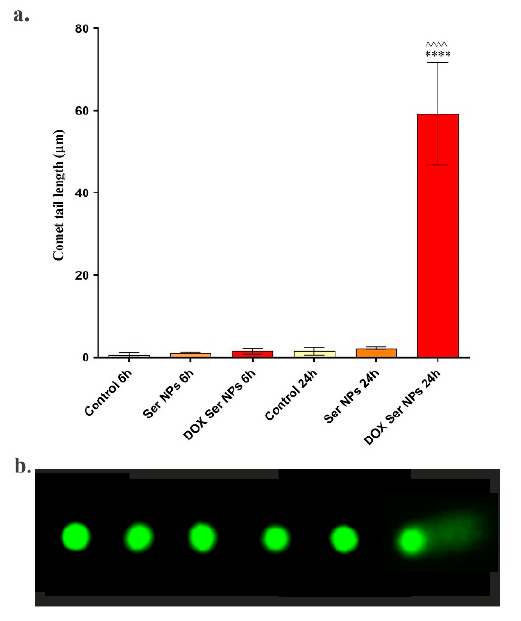
Figure 12. ( a ) Graphical representation showing the comet tail length as an indicator of DNA damage in MCF–7 cell cultures treated for 6 h and 24 h with simple and DOX-loaded Ser NPs (Dox Ser NPs vs. untreated control **** p ≤ 0.0001; Dox Ser NPs vs. Ser NPs ˆˆˆˆ p ≤ 0.0001); ( b ) representative fluorescence micrographs of the comet-like structures in MCF–7 cell cultures treated for 6 h and 24 h with simple and DOX-loaded Ser NPs .